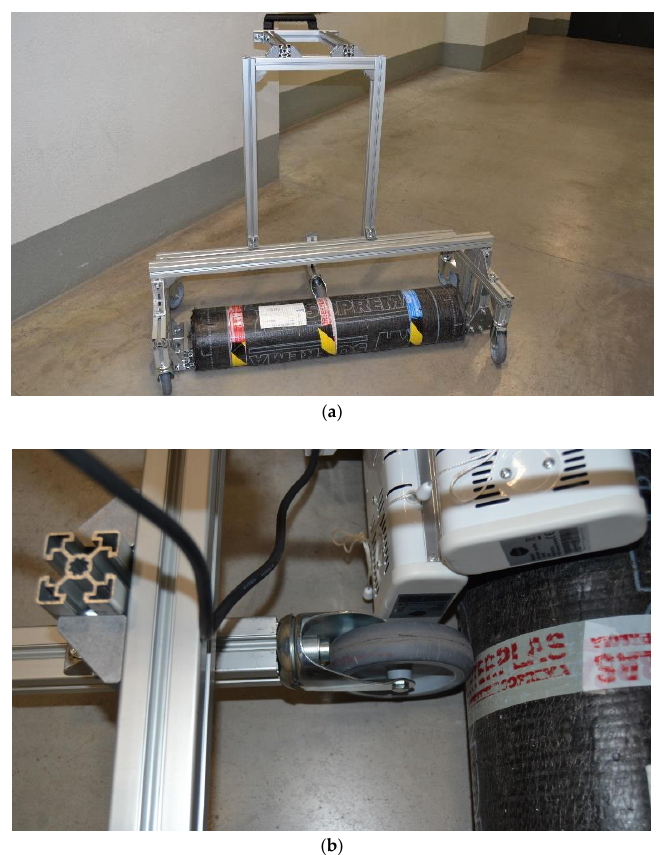
Figure 9. ( a ) Main frame made on 45 × 45 mm aluminium profiles and roll, and ( b ) auxiliary wheel against the roll.